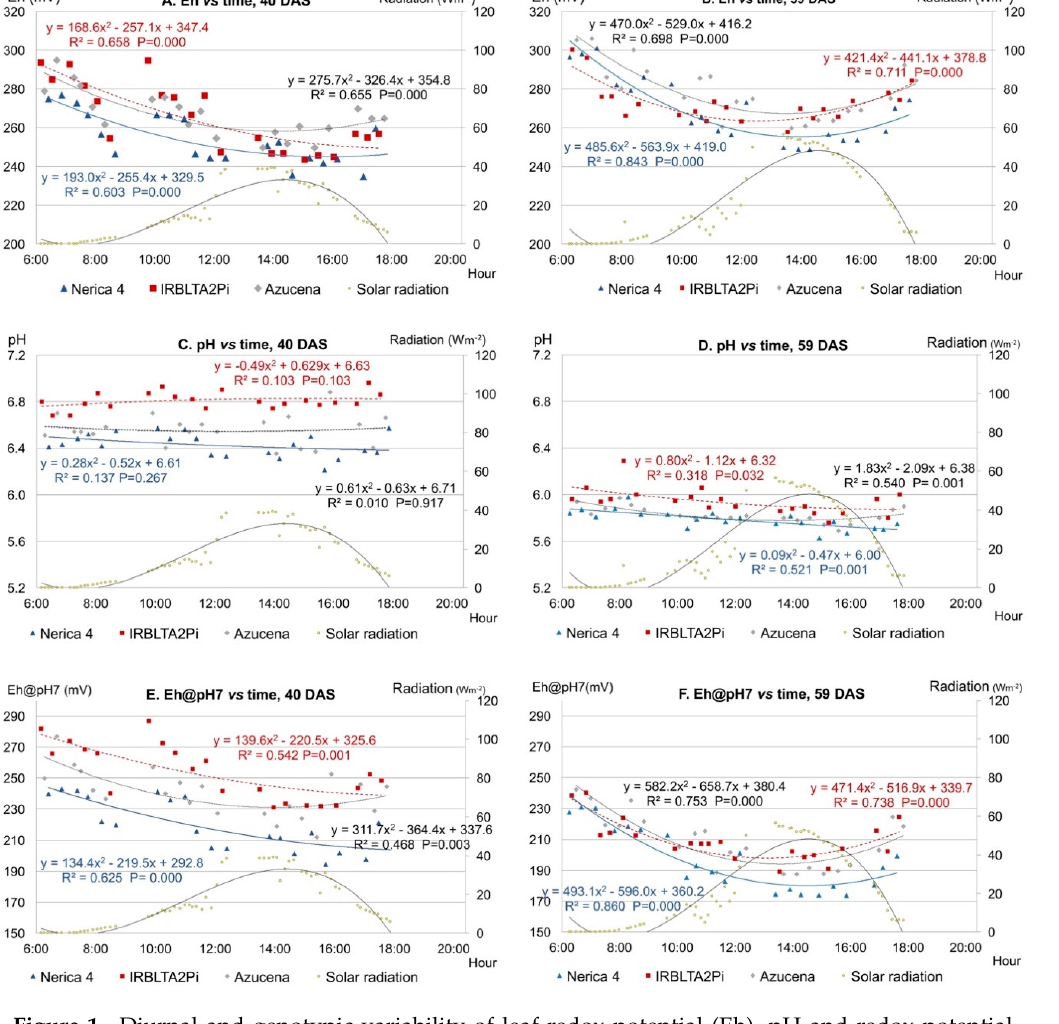
Figure 1. Diurnal and genotypic variability of leaf redox potential (Eh), pH and redox potential corrected to pH 7 (Eh@pH7) at two plant ages (40 and 59 DAS) for three rice varieties (Nerica4, IRBLTA2Pi, Azucena). Regression equations over time and strength of the relationship ( R 2 and p values) are given for each variety. ( A , B ). Diurnal changes in Eh (mV) for the two plant ages. ( C , D ) Diurnal changes in pH for the two plant ages. ( E , F ). Diurnal changes in Eh@pH7 (mV) for the two plant ages.